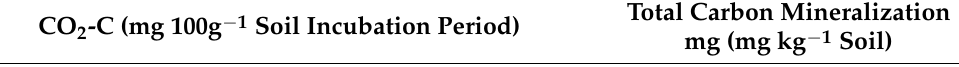
Table 9. Basal respiration in soil determined as gross flux of CO 2, amended with different concentra- tion of sewage sludge during different time